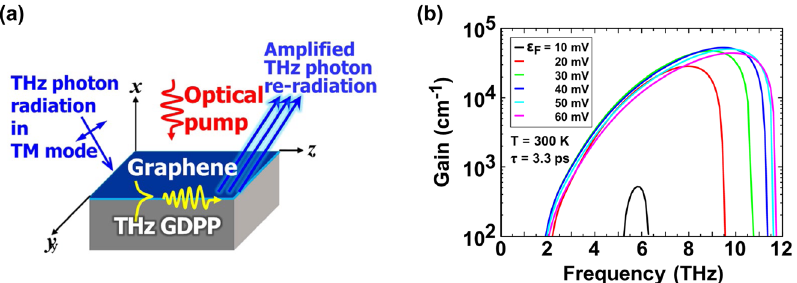
Figure 4: The giant gain enhancement effect of GDPPs on THz stimulated emission in optically pumped monolayer graphene. Adapted with permission from ref. [43]. Copyright 2013, IOP Publishing Ltd. and Deutsche Physikalische Gesellschaft. (a) Schematics of the GDPP excitation. (b) Numerically simulated gain spectra for monolayer population-inverted graphene on SiO 2 /Si substrate at 300 K for different quasi-Fermi energies ε F = 10, 20, 30, 40, 50 and 60 meV. Carrier momentum relaxation time τ in graphene is τ = 3.3 ps. The results demonstrate giant THz gain (negative values of absorption) of the order of 10 4 cm − 1